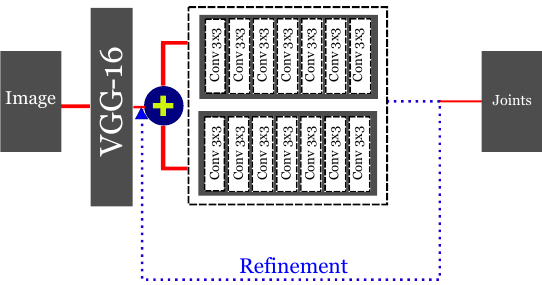
Figure 1. Joint Detection Architecture: Images are fed to VGG16, and generated feature maps are fed to a two branch network. Branch 1 (top) finds the confidence map for a labeling a joint. Branch 2 (bottom) is in charge of estimating the orientation of the limb between two detected joints the image space becomes larger and larger. In other words, his